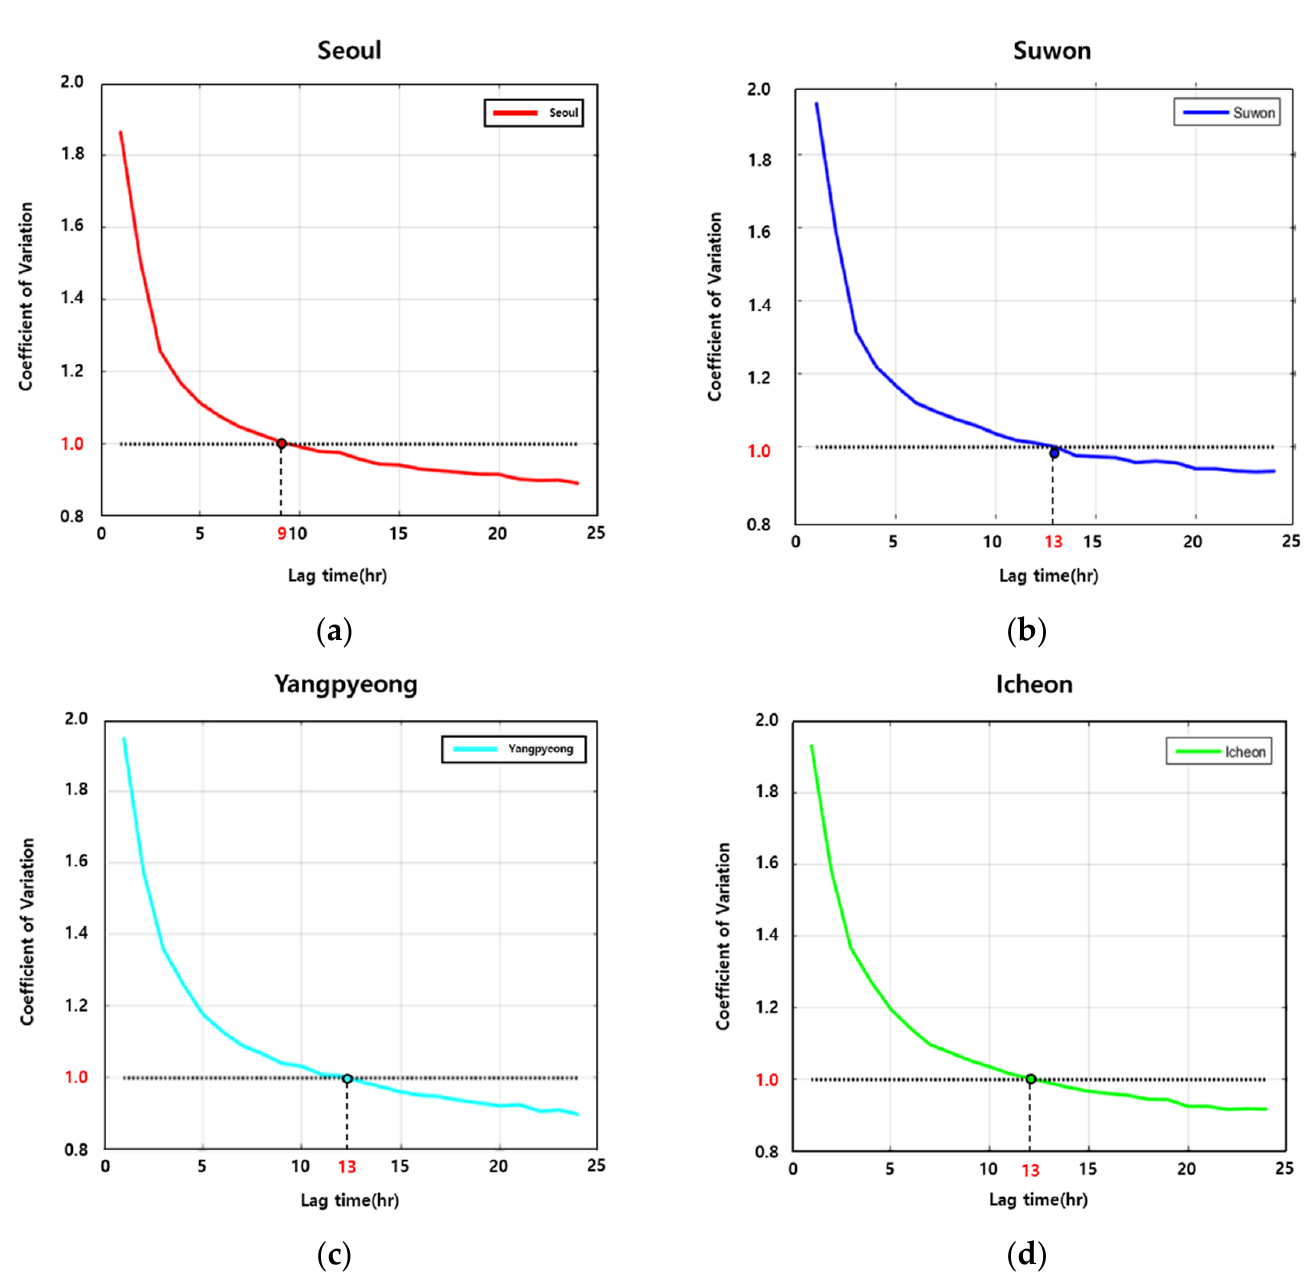
Figure 5. Selection of IETD from the coefficient of variation; ( a ) Seoul station (9 h), ( b ) Suwon station (13 h), ( c ) Yangpyeong station (13 h), ( d ) Icheon station (13 h)